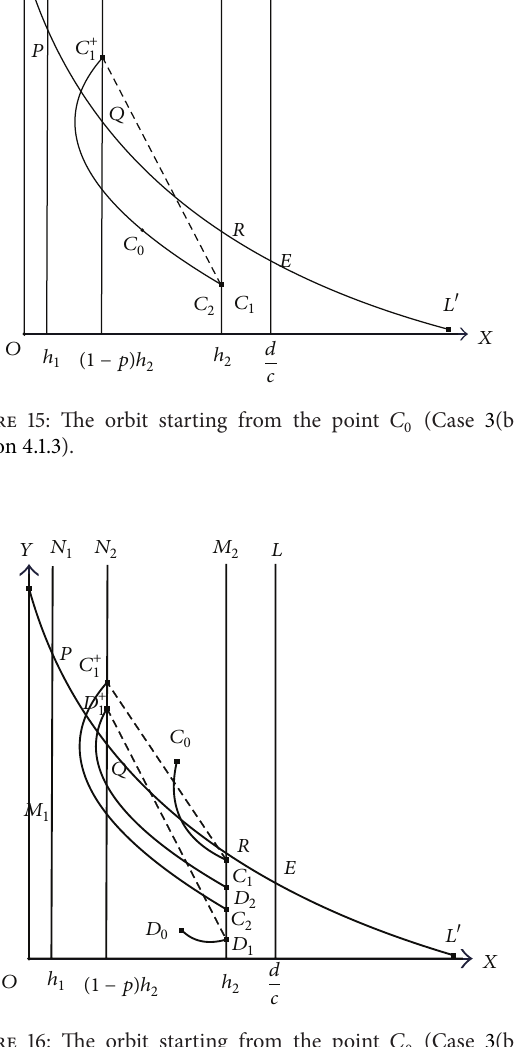
Figure 16: The orbit starting from the point 𝐶 0 (Case 3(b) in Section